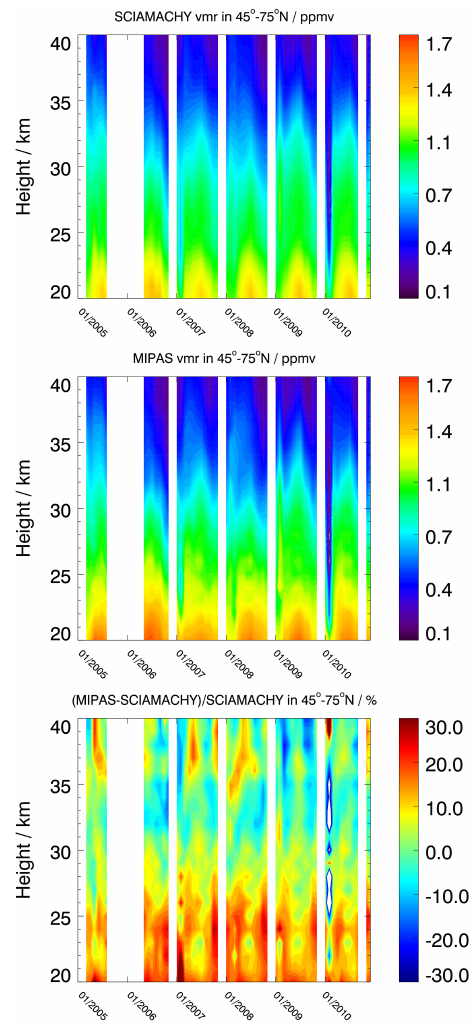
Figure 9. Monthly mean values of SCIAMACHY (top panel) and MIPAS (middle panel) and monthly means of differences (MIPAS– SCIAMACHY)/SCIAMACHY in percent (bottom panel) in 2005–